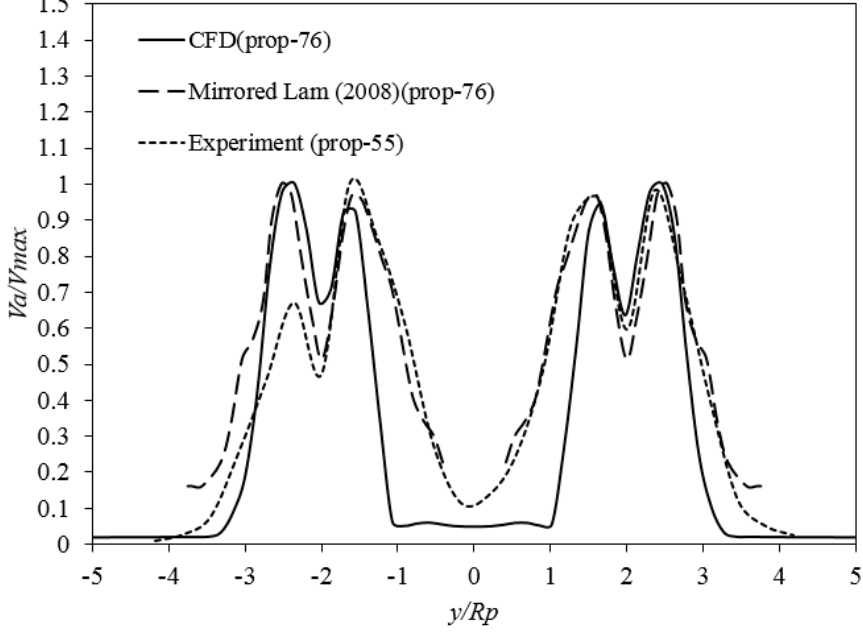
Figure 4. Axial velocity distribution at 1 Dp within ZFE-TP-4P.